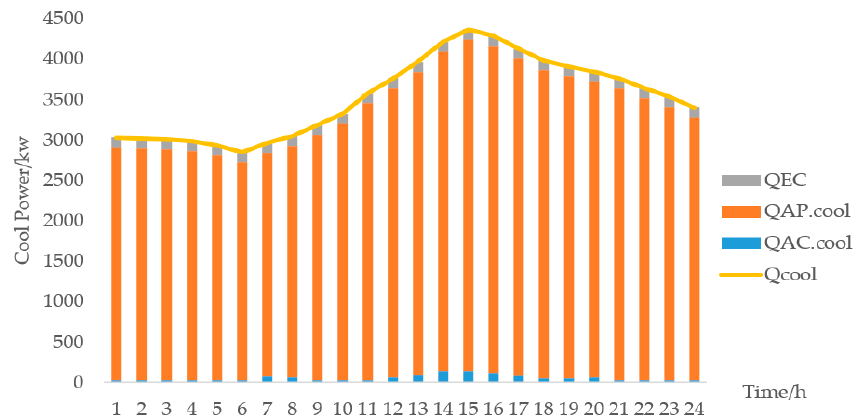
Figure 16. Cooling output diagram of various equipment before single time scale in summer.